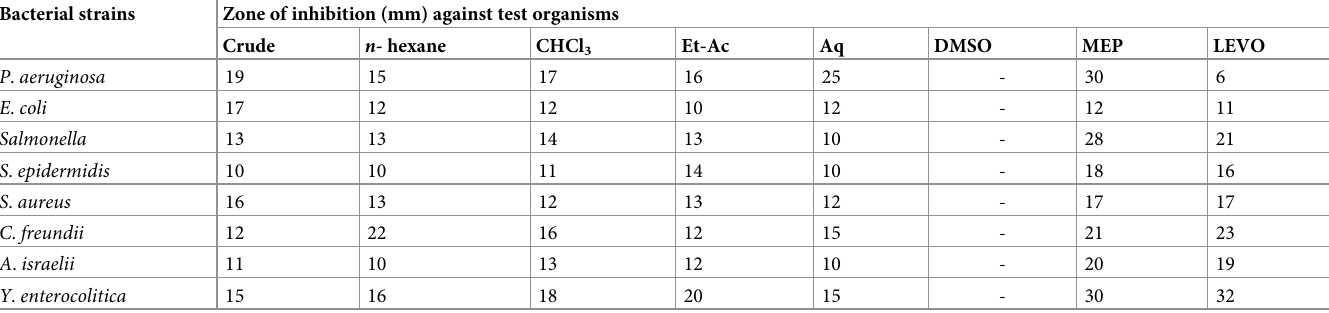
Figs 1 and 2 represents zone of inhibition of extracts against specific bacteria. Anti-fungal activity of I . albicans . The crude and fractions were subjected to antifungal assay using nystatin and fluconazole as standard drugs. Fungal strains used in the study included aspergillus niger , aspergillus flavus and penicillium . The crude and corresponding fractions were effective against A . niger while DMSO was used as solvent and was inactive against all fungal strain as shown in Table 3.